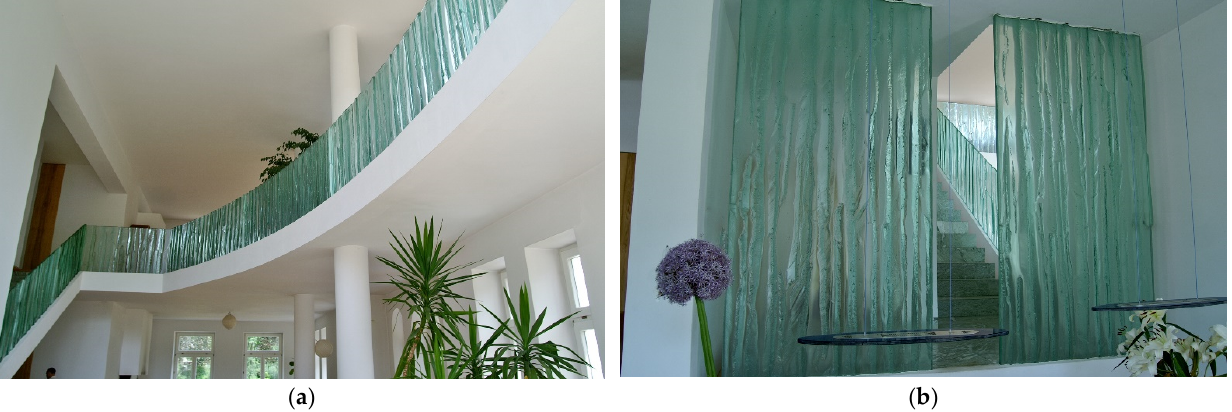
Figure 15. Interiors featuring glass elements by Tomasz Urbanowicz at the Palace in Opypy, Poland, 2000: ( a ) continuous balustrade of kiln-formed glass embedded in the floor; ( b ) dominant greenish cast-glass walls and decorative elements in a neutral interior design (Tomasz Urbanowicz).